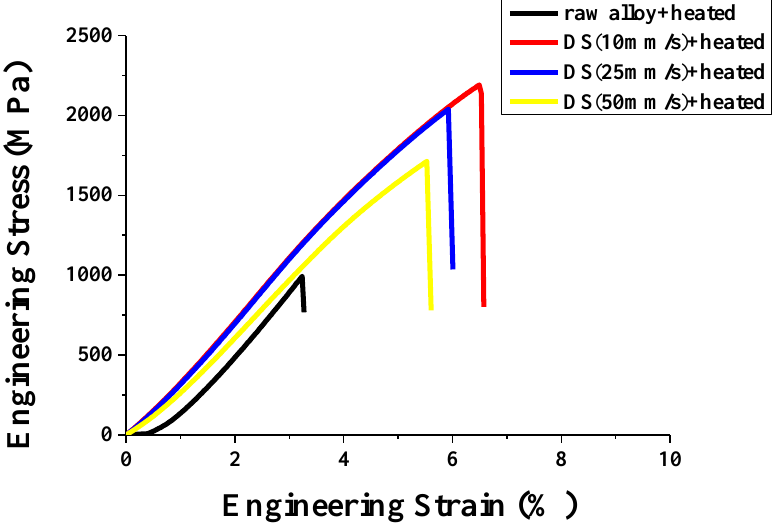
Figure 4. Tensile test stress-strain curve of each specimen. Tensile strength decreased with increasing solidification or primary austenite dendrite fraction or decreasing eutectic structure fraction. Except for the difference in ultimate tensile fracture strength, all the specimens showed similar elastic tensile behavior in the stress-strain curve. It means that the tensile behavior of the specimens was governed by the non-deformable hard phase. The eutectic composition of high Cr white iron has a phase fraction ratio of austenite: M 7 C 3 = 2.76:1 [2]. As appeared in Figure 4, the microstructure of the DS specimen solidified at and lower than 10 µ m/s is a fully austenite/M 7 C 3 eutectic structure. The typical microstructure of the DS specimen is displayed in Figure 5. The phases grew along the solidification direction (Figure 5a) and distributed relatively uniformly at a low solidification rate (Figure 5b). The feature of the microstructure is austenite/M 7 C 3 in situ composites, similar to (Co, Cr)–Cr 7 C 3 in situ composite [6]. The ultimate tensile stress of the in situ composite is rigorously given by the Rule of Mixtures, the average of the individual phases [6]. The tensile and fracture behavior is dependent upon the strength and volume fraction of individual phases [6].